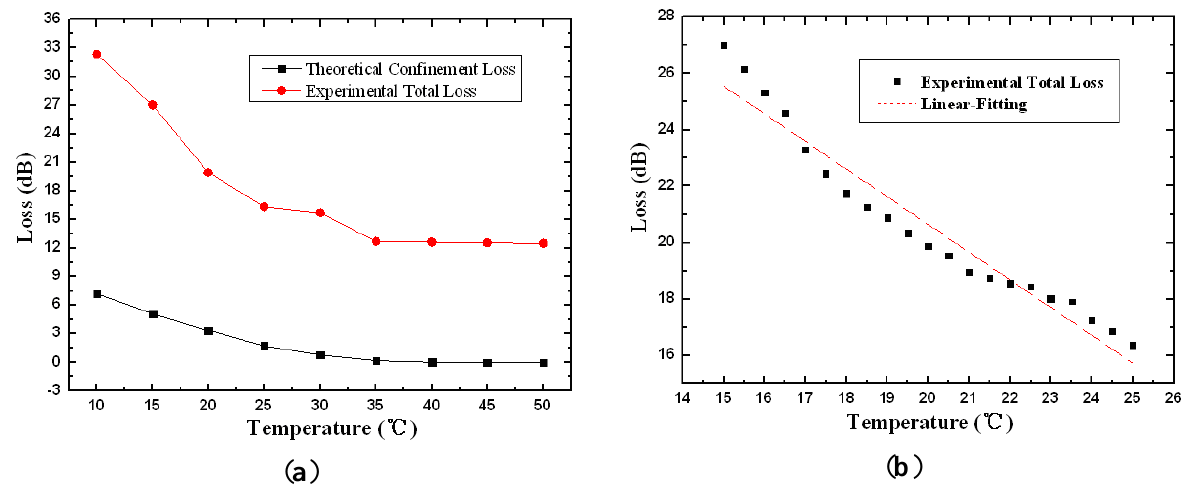
Figure 6. Theoretical and experimental loss ( a ) and linear fitting curves of the experimental loss ( b ) as functions of temperature with pure